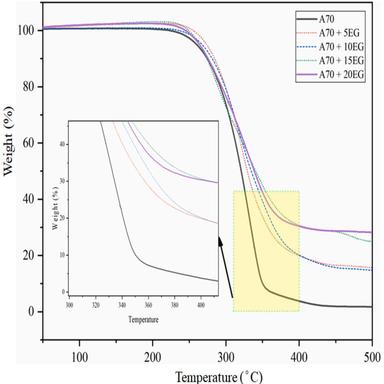
Decomposition temperature analysis curves of base PCM and the developed SS-PCM composites.